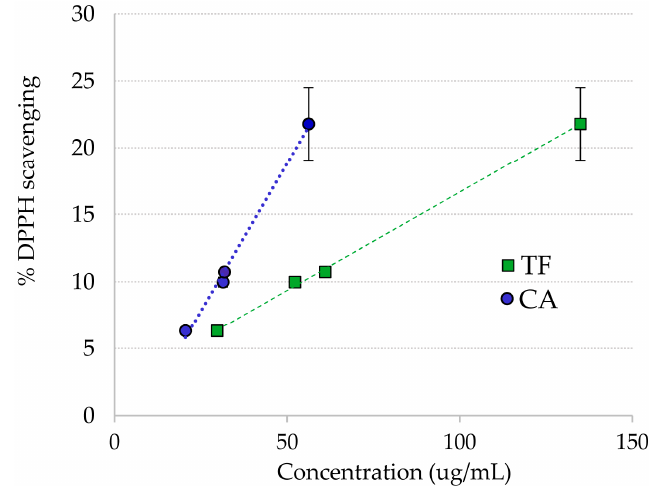
Figure 3. DPPH· radical scavenging vs. concentration of chicoric acid ( CA ) and total flavonoids (TF) in Ruppia cirrhosa crude extracts.